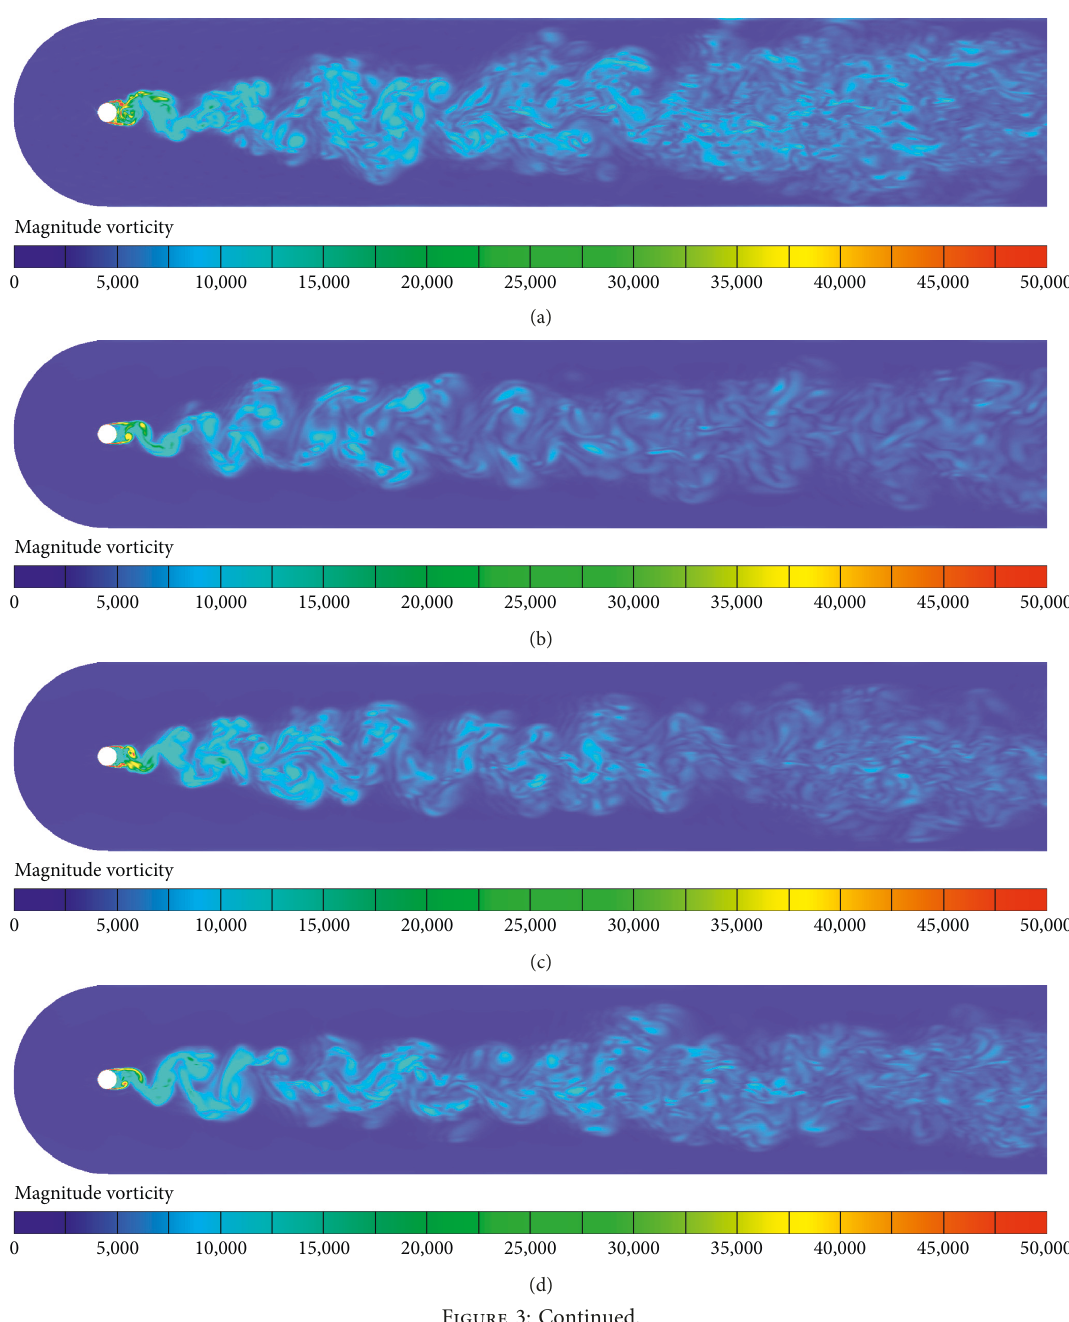
Figure 2: Middle intersection mesh on the radial direction of the cylinder: (a) the global mesh; (b) the locally enlarged mesh near a cylinder.